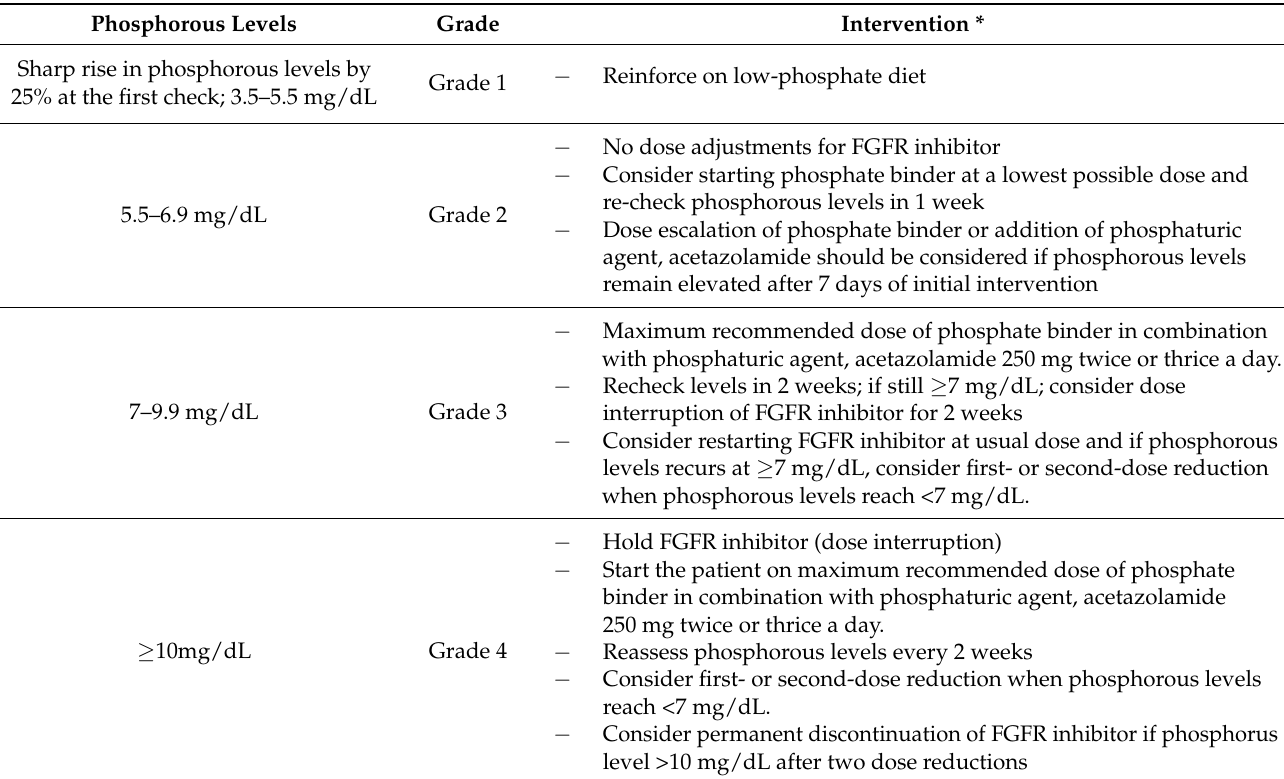
Table 5. Guidance for the management of FGFR-inhibitor-associated hyperphosphatemia. Phosphorous Levels Grade Intervention * Sharp rise in phosphorous levels